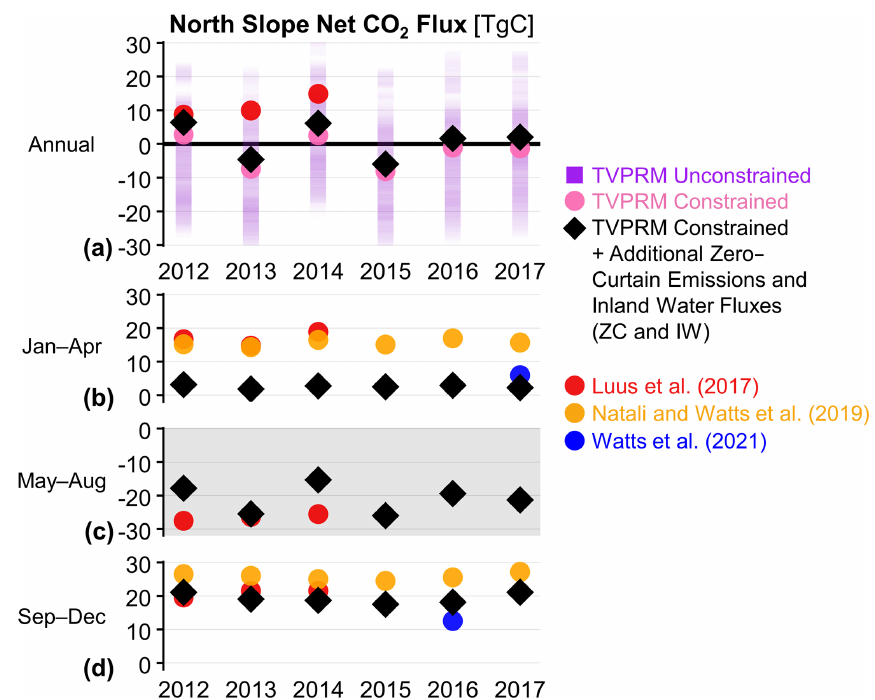
Figure 5. Annual and seasonal Alaska North Slope net CO 2 flux constrained by aircraft and tower observations. (a) Annual, (b) late-cold- season (January–April), (c) growing-season (May–August), and (d) early-cold-season (September–December) total Alaska North Slope net CO 2 fluxes for various CO 2 flux models for 2012–2017, as in Fig. 4. Purple squares indicate the middle 95% of all TVPRM ensemble